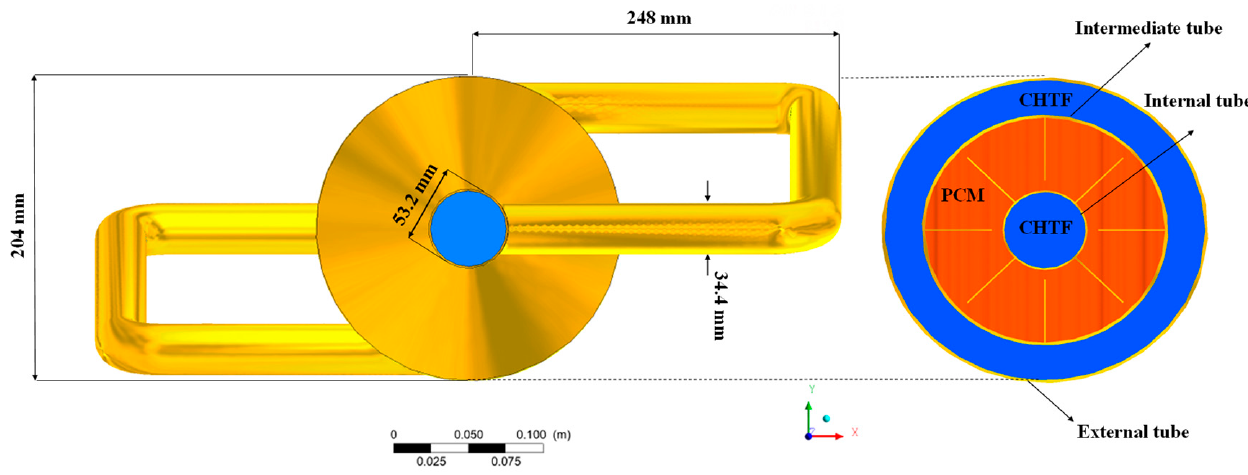
Energies 2023 , 16 , x FOR PEER REVIEW Figure 2. Front view and cross section of the TTXH. Figure 2. Front view and cross section of the TTXH.